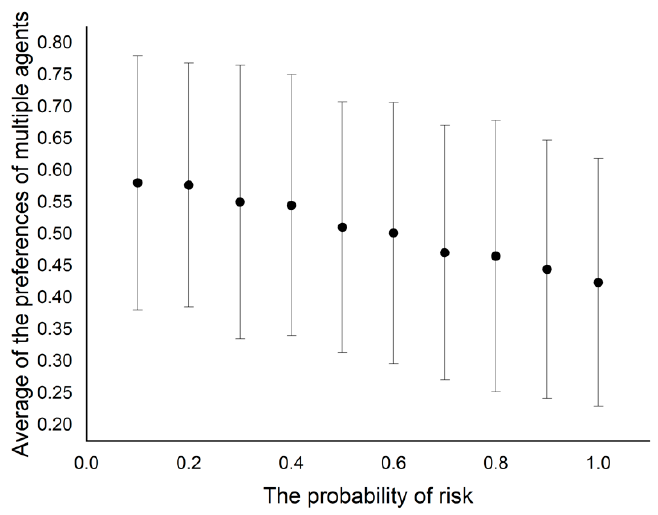
Figure 8. Variation of individuals’ risk preference over the risk range.